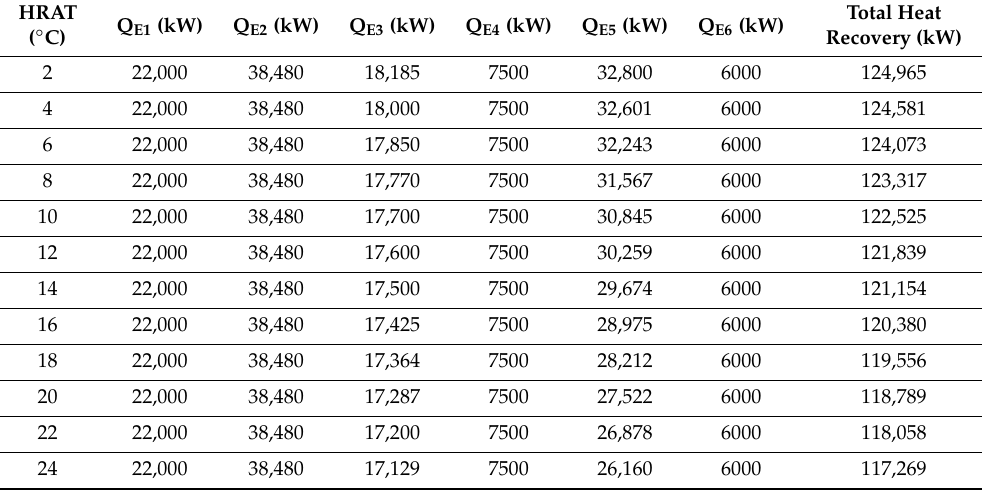
Table A5. Exchangers heat duties for HEN at di ff erent HRAT values using option 2.